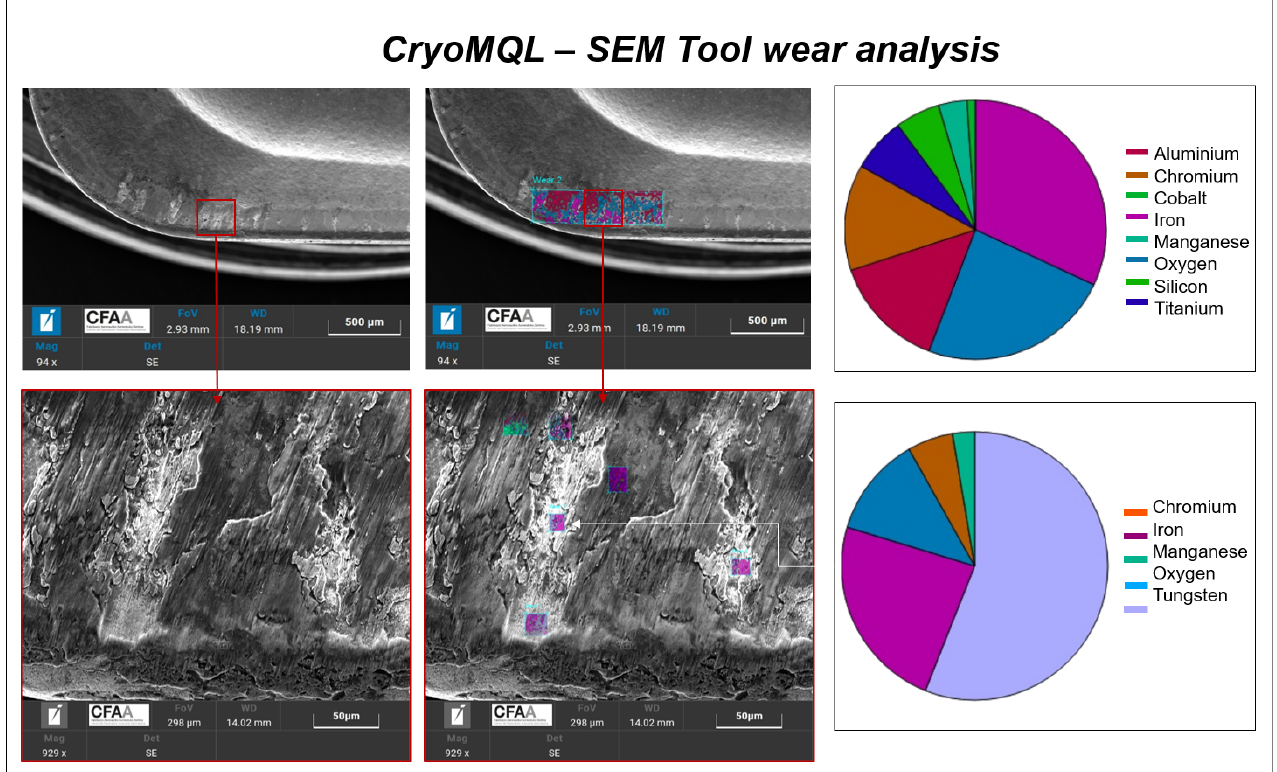
Figure 5. CryoMQL tool wear material analysis.